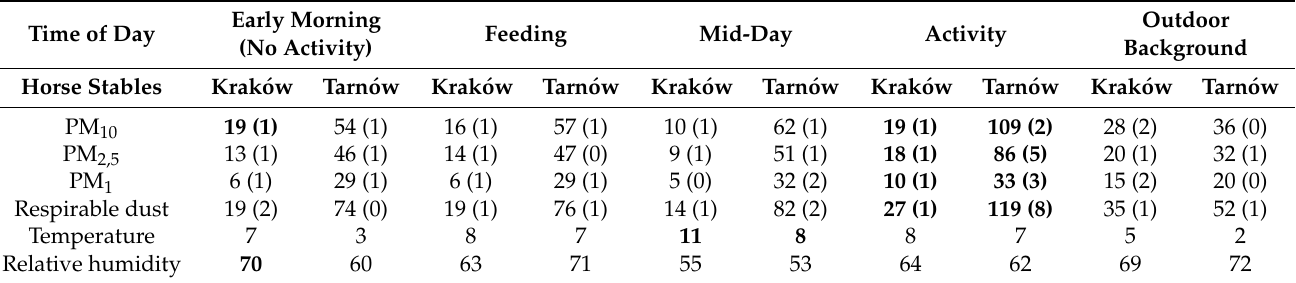
Table 1. Mean values of particulate matter concentration ( µ g/m 3 ) along with temperature ( ◦ C) and relative humidity (%) in the examined horse stables and outdoors. The presented values are means of six replicates from one hour intervals. Values in brackets show standard deviation. The highest values recorded indoors are shown in